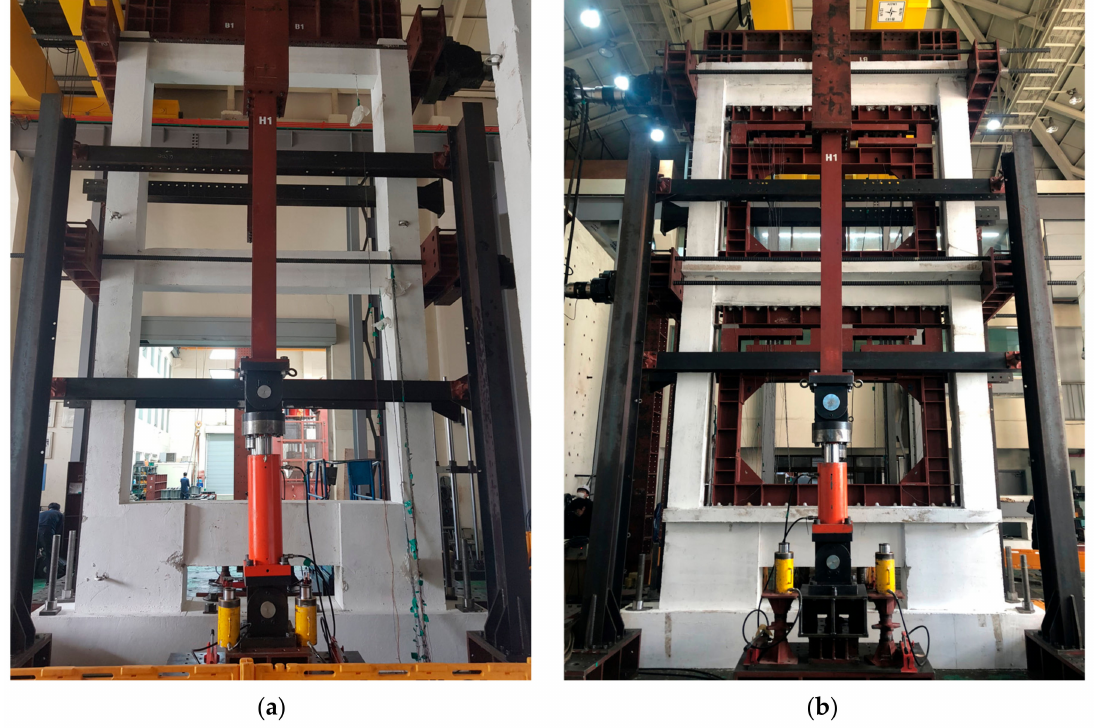
Figure 12. Images of the test specimens: ( a ) existing frame with no reinforcement applied (PD-FR) and ( b ) frame retrofitted with the NBSD-WSCS (PD-NBSD-WSCS).